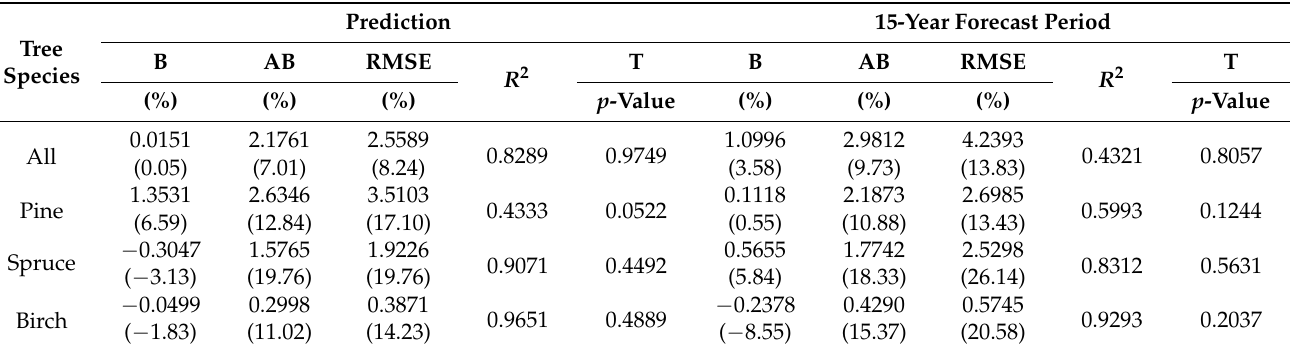
Table 11. Statistical measures and p -values of the Student’s t -test for the prediction and forecast of the stand basal area per